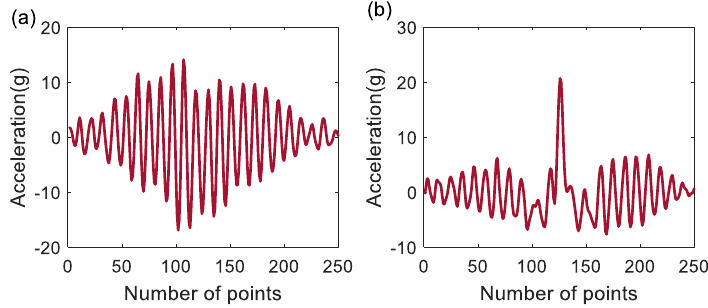
Figure 7. The defect in ( a ) outer surface of inner ring and ( b ) inner surface of outer ring of NU306 bearing.